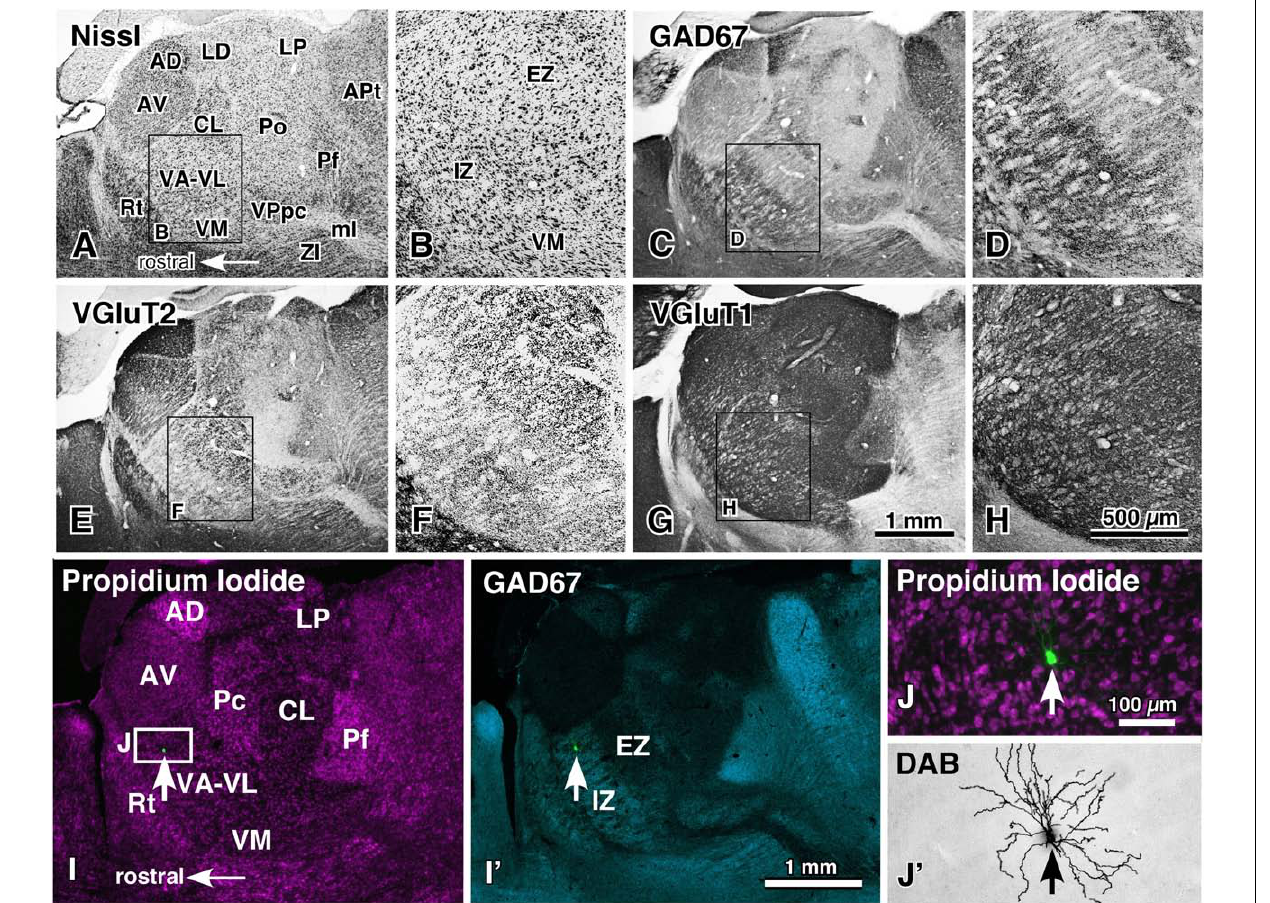
FIGURE 1 | Motor thalamic nuclei and single-neuron labeling with a viral vector expressing membrane-targeted GFP. The motor thalamic complex VA–VL of rats is divided into two portions, IZ and EZ (A,B) .The rostroventrally located IZ receives abundant basal ganglia inputs that are large varicosities immunoreactive for GAD67 (C,D) , whereas the caudodorsally situated EZ admits cerebellar inputs consisting of many giantVGluT2-immunoreactive terminals (E,F) .Thus, the two portions are called inhibitory input-dominant zone (IZ) and excitatory subcortical input-dominant zone (EZ), respectively. In contrast, fine cortically derivedVGluT1-immunoreactive axon terminals are distributed rather homogeneously not only in theVA–VL, but also in the entire thalamic nuclei (G,H) .When an appropriately diluted solution of viral